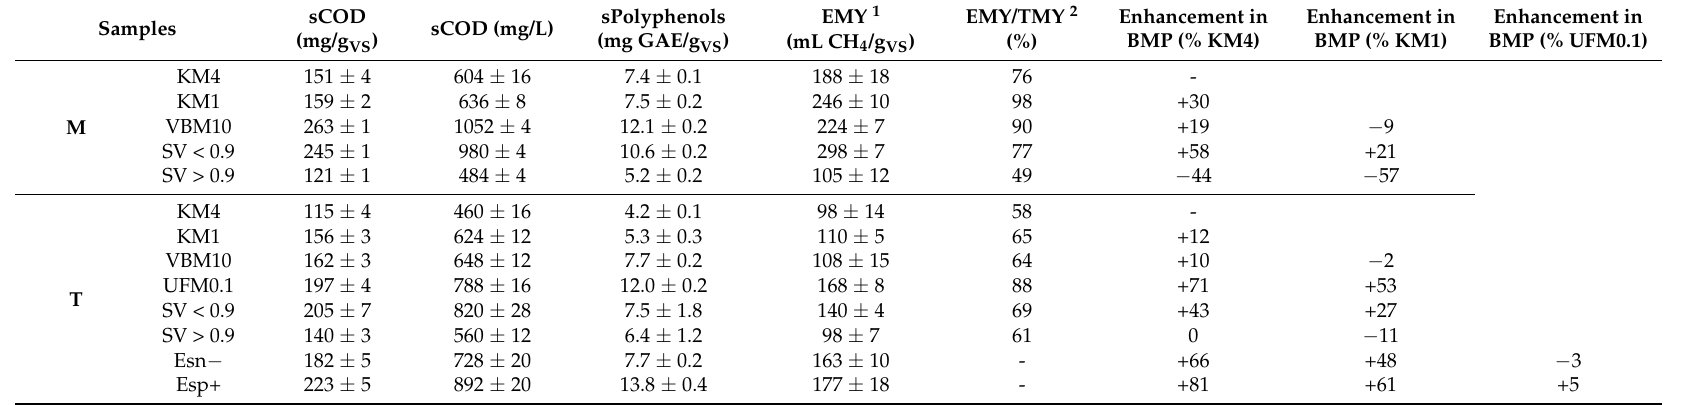
Table 2. Methane production and solubilization